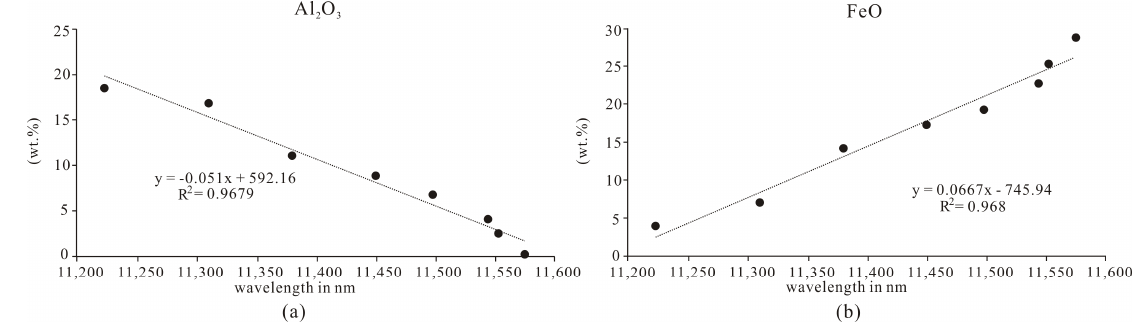
Figure 6. Correlation between garnet wavelength and content of Al 2 O 3 , FeO ( a , b ). Table 2. EPMA analysis results (wt%) and absorption peak of